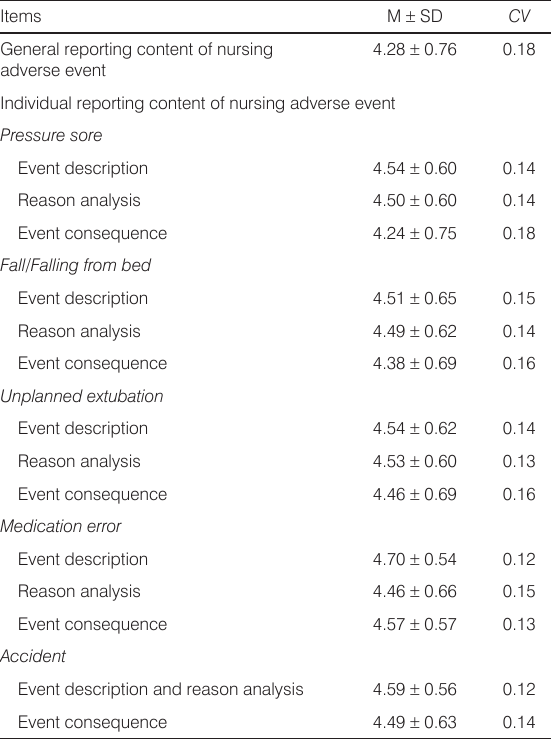
Table 2. Means, standard deviations, and variable coefficients of